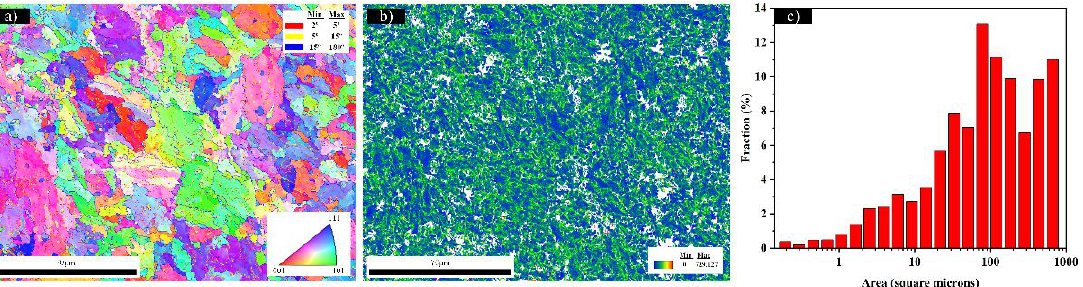
Figure 18. Microstructure information of sample E. ( a ) EBSD orientation map; ( b ) GND map; ( c ) grain area distribution.